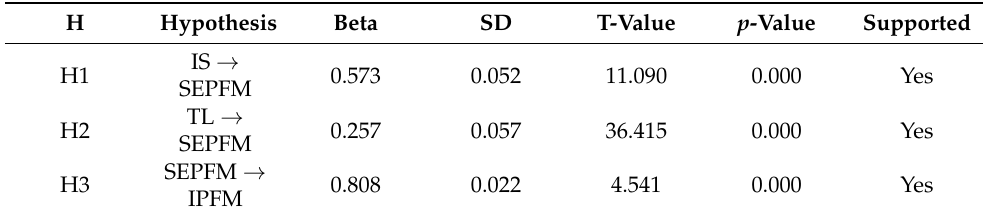
Table 4. Convergent validity and discriminant